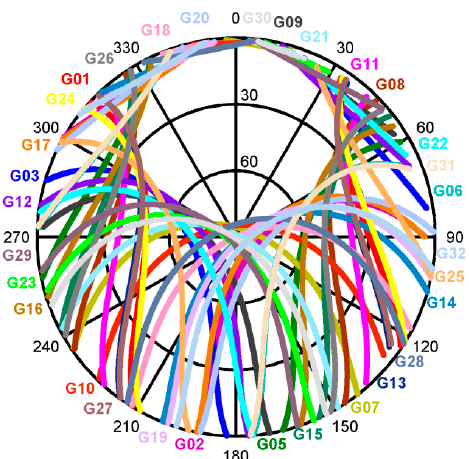
Figure 1. Twenty-four hour skyplot of visible GPS satellites observed from the permanent reference station.